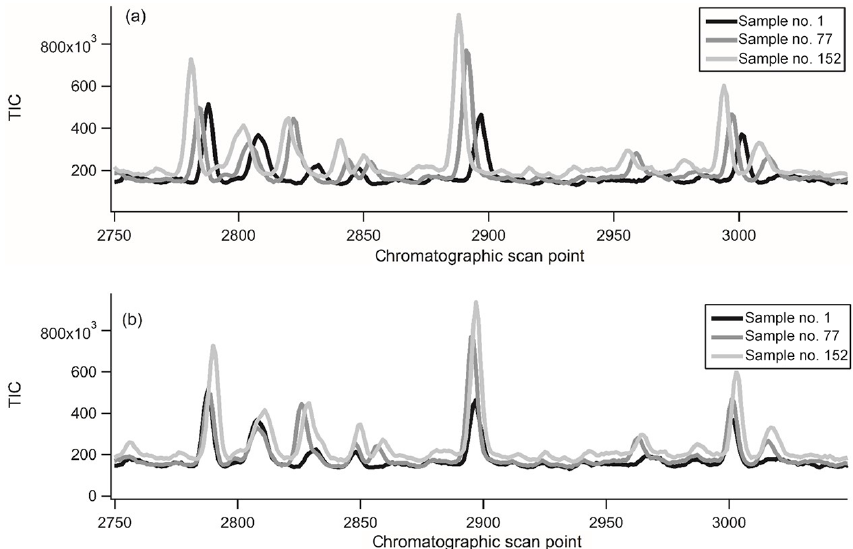
Figure 2. Excerpts of chromatogram for the beginning, middle, and end of the study focus period (a) before retention time shift, and (b) after retention time shift. The sample collection times for no. 1, 77, and 152 are 29 July 2005 at 00:00, 3 August 2005 at 08:00, and 8 August 2005 at 07:00,